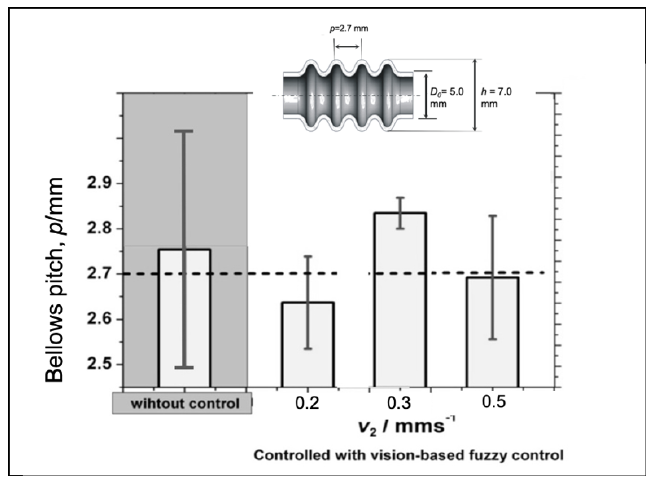
Figure 21. Evaluation of the bellows pitches under different initial compression speeds.